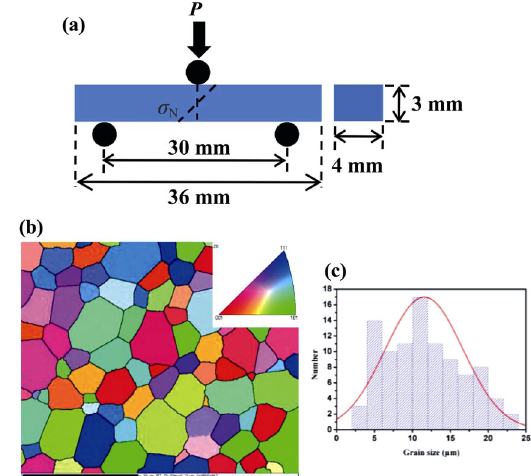
Fig. 6 (a) A diagrammatic sketch of three-point bending test, (b) EBSD orientation map, and (c) grain size distribution of YAG transparent ceramic